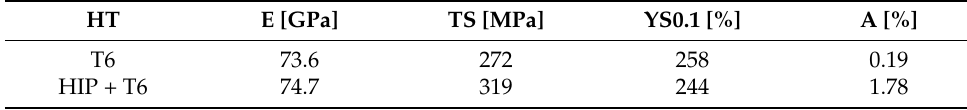
Figure 2. Comparison of SDAS values at Positions A–D for high-porosity (HP) and low-porosity (LP) regions in each specimen. Table 2. Quasistatic properties of the investigated material.